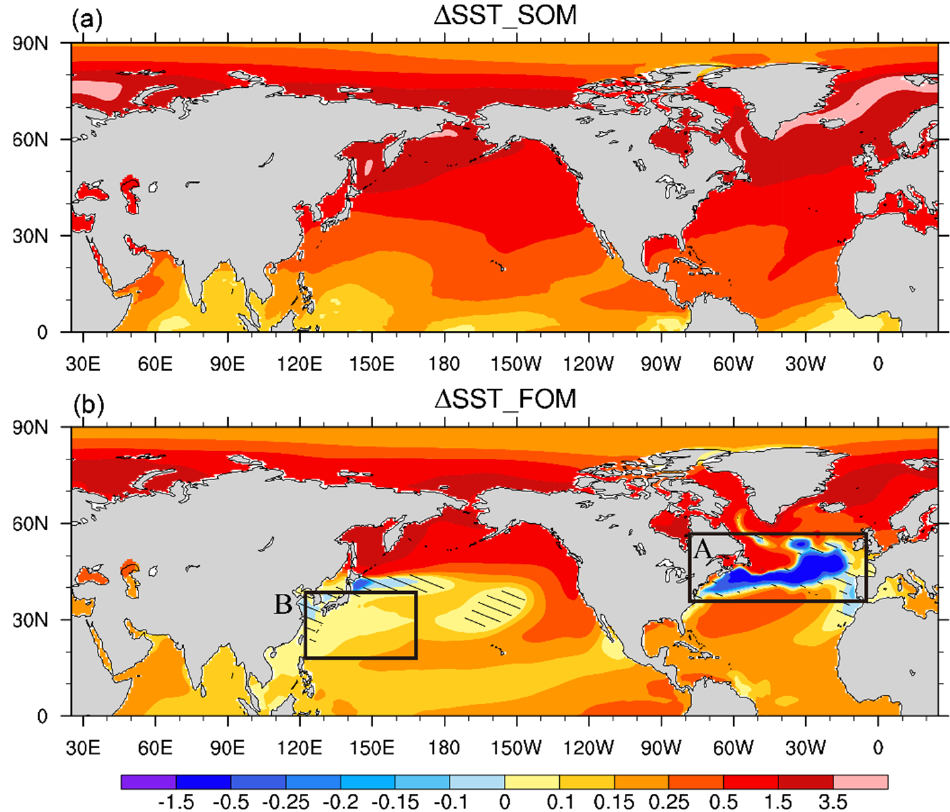
Figure 2. The quasi-equilibrium response of sea surface temperature (SST, ℃ ) to Arctic sea ice loss in ( a ) SOM and ( b ) FOM. Values not significant at the 95% confidence level are hatched. Black box A shows the position of the Gulf Stream and its extension. Black box B represents the position of the Kuroshio and its extension.